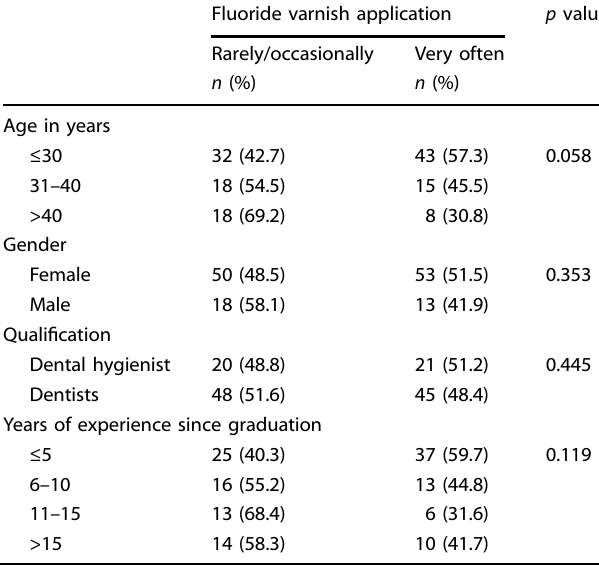
Table 5. Relationship between demographic characteristics and placing fl uoride varnish for caries prevention and